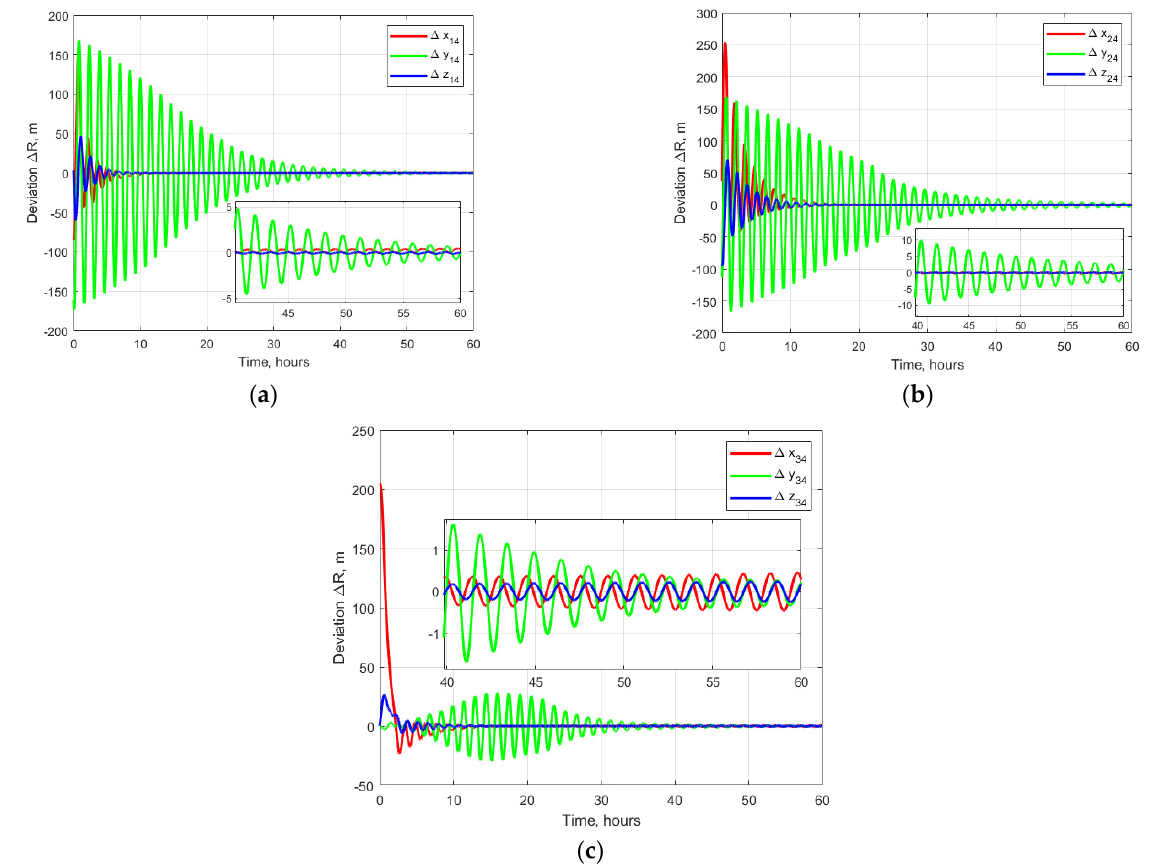
Figure 5. Satellite position vector deviations relative to the fourth satellite: ( a ) first relative to the fourth satellite ∆ R 14 , ( b ) first relative to the fourth satellite ∆ R 24 , and ( c ) first relative to the fourth satellite ∆ R 34